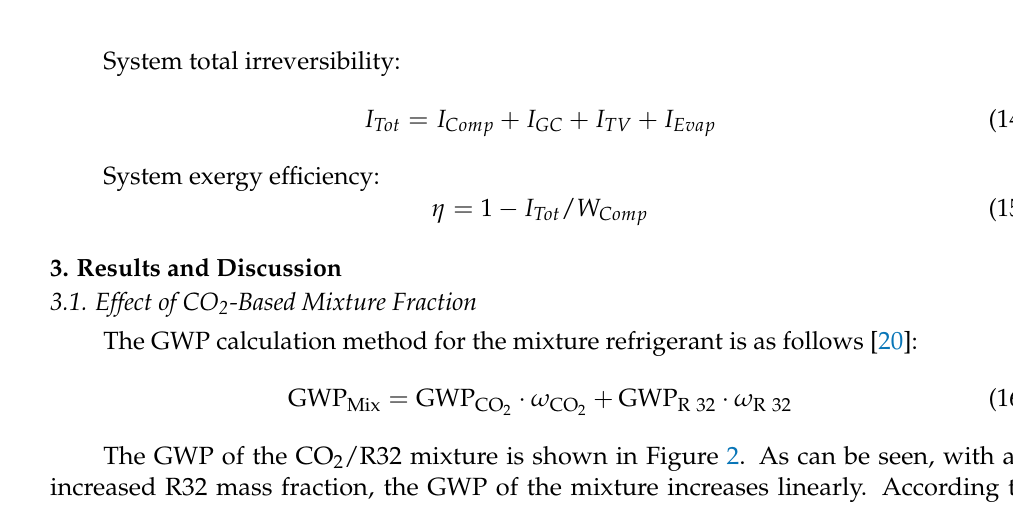
Figure 3. Critical temperature and critical pressure of the CO 2 -based mixture. In order to compare the effect of the mass fraction of R32 on the system’s maximum COP, the calculated COP results at the optimal discharge pressure, at an ambient temperature of 15 °C, are depicted in Figure 4. Interestingly, the COP variation is not increased or decreased in a straight upward or downward trend. Instead, the variation shows a trend similar to that of the letter “M”. When compared to the COP for a system